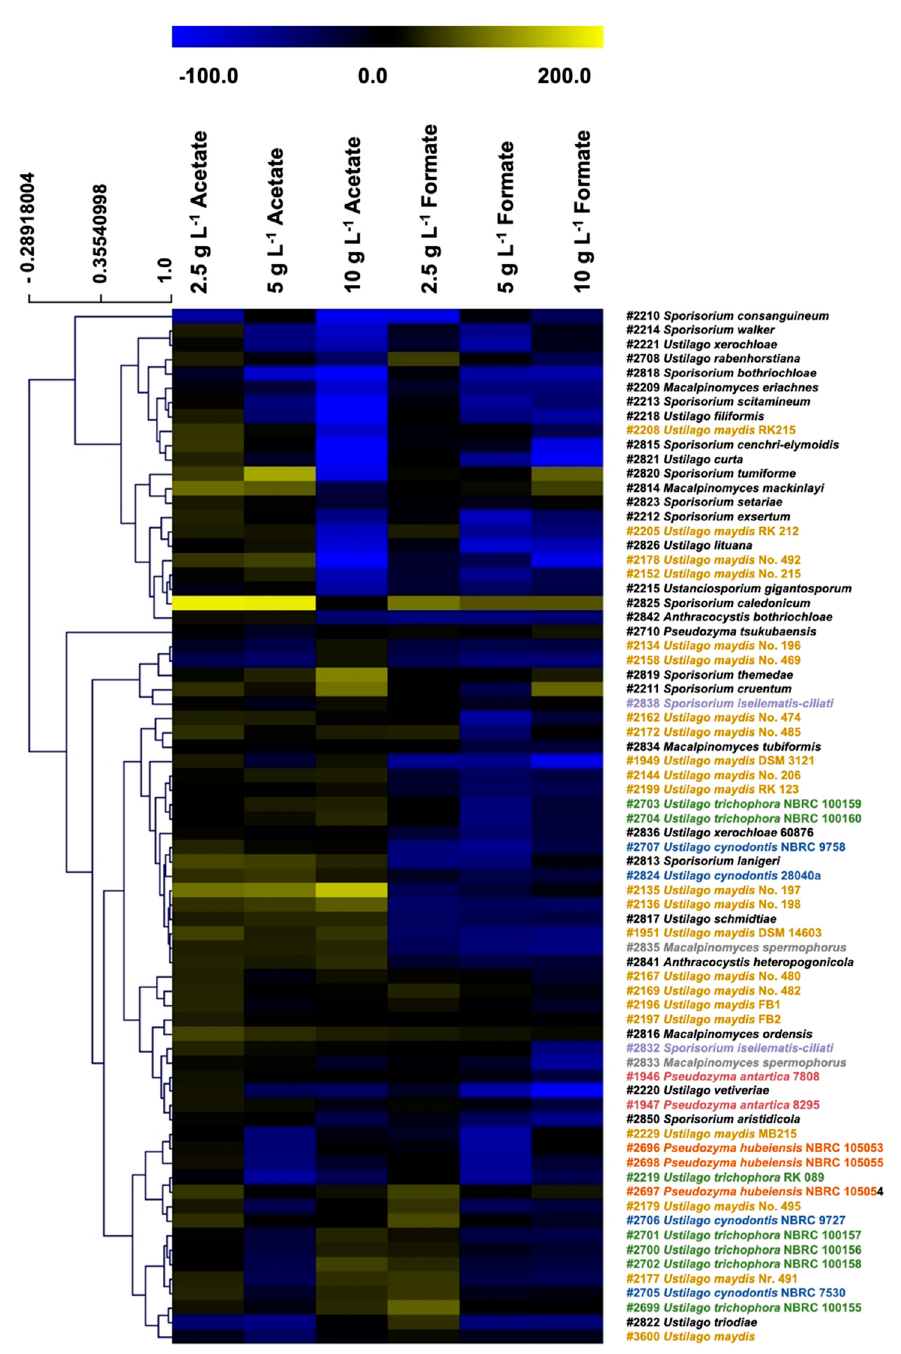
Figure 2. Overview of biodiversity screening results. Hierarchical cluster analysis (HCA) heatmap showing whole set growth screening results obtained during 24-deep-well plate cultivation in MTM medium with 4 g L − 1 NH 4 Cl using the Growth Profiler system by EnzyScreen. Strains were cultivated for growth on both co-substrates under various conditions of 2.5, 5.0, and 10.0 g L − 1 in combination with 20.0 g L − 1 glucose. Maximum optical density (OD 600 ) was normalized to the growth of the respective glucose reference and visualized via color scales in the HCA heatmap indicating relative growth [%] Blue color indicates a lower growth, black a comparable growth behavior, and yellow a higher growth compared to the respective glucose reference. Strains belonging to one species were colored accordingly in the displayed rows. Experiments were performed with two biological duplicates. Raw data are provided in Supplementary Materials (Tables S2 and